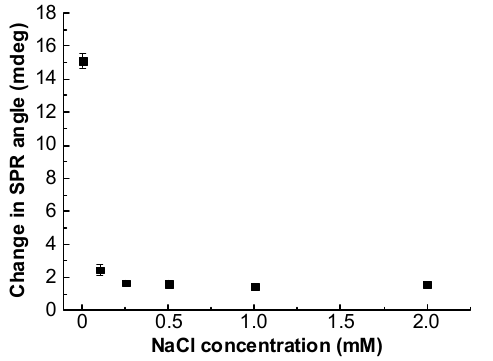
Figure 12. E ff ect of ionic strength (NaCl concentration) on the glyphosate sorption onto CS / ZnO SPR Figure 12. Effect of ionic strength (NaCl concentration) on the glyphosate sorption onto CS/ZnO SPR sensor at 0.30 μ M glyphosate and pH 5.5. sensor at 0.30 µ M glyphosate and pH